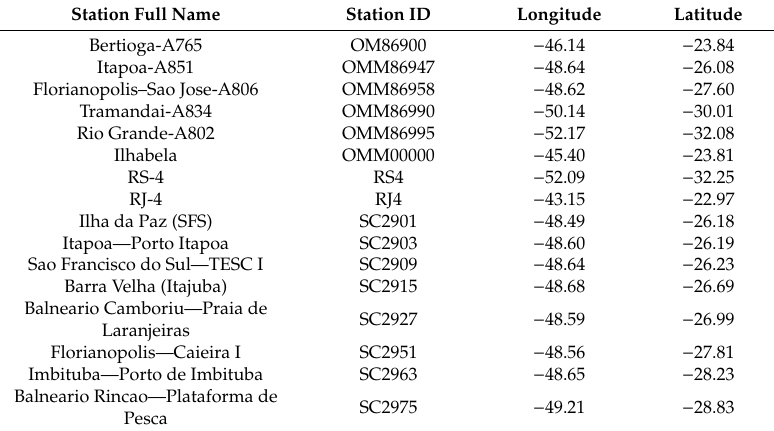
Table 1. List of recording stations used in the case